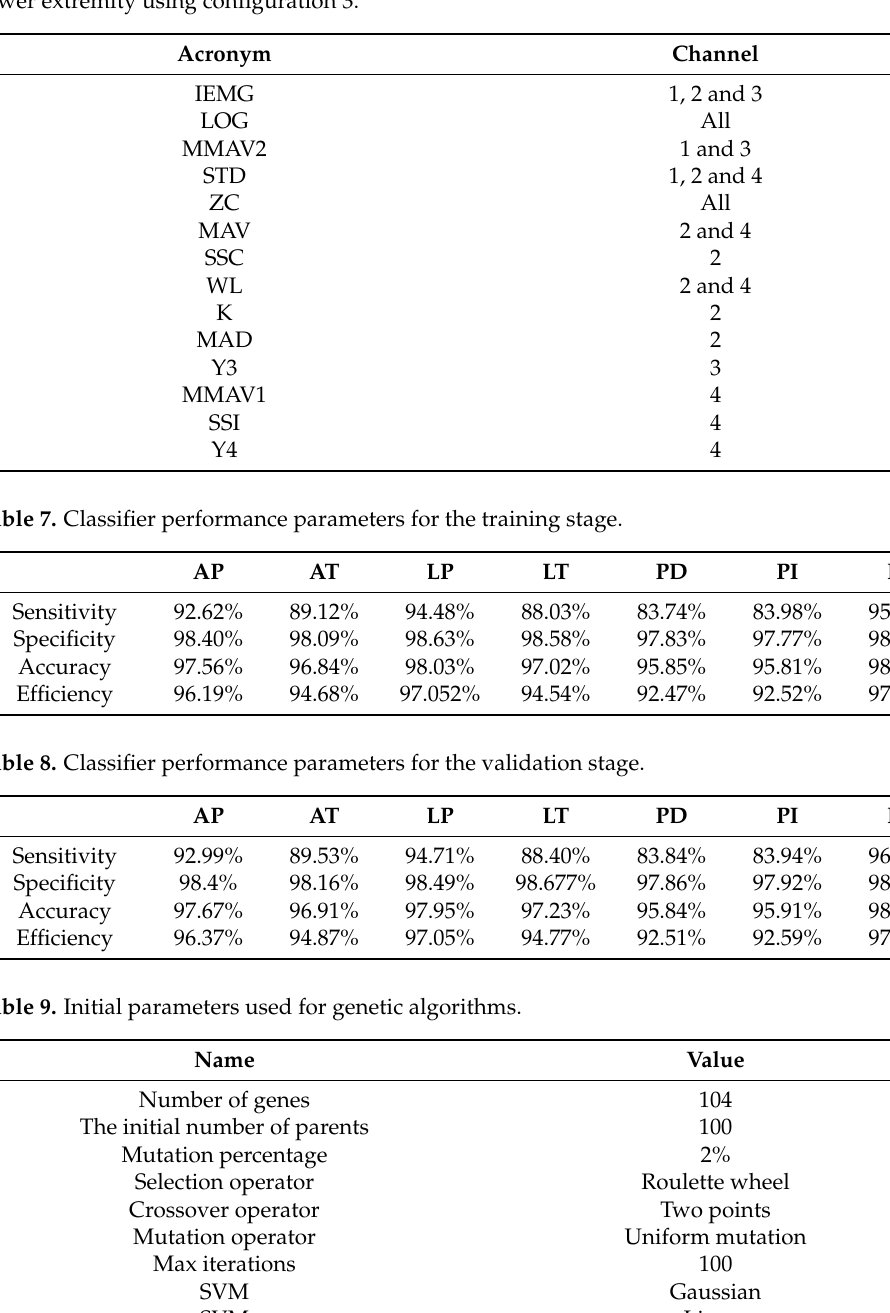
Table 6. Features selected as the best subset of characteristics for classifying signals from the right lower extremity using configuration 3.